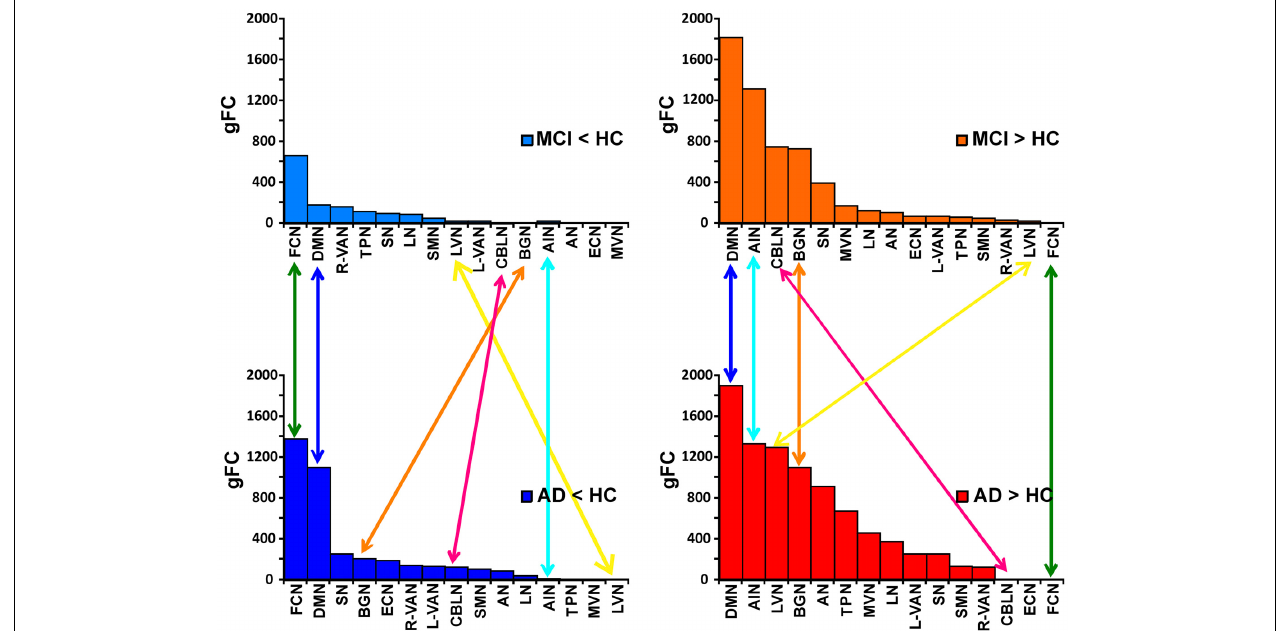
FIGURE 4 | Ranking of gFC changes in MCI and AD. In order to better identify the patterns of gFC changes within the networks, for each contrast (MCI < HC, MCI > HC on the top; AD < HC, AD > HC on the bottom of the picture) we ranked the RSN alterations in terms of their decreasing gFC . We identified 6 different prototypical patterns: (1) FCN (green arrows) showed the largest gFC reduction, both in AD and MCI, and no increase in any conditions; (2) AIN (turquoise arrows) showed no gFC reduction, either in AD or MCI, but it showed a large increase in both